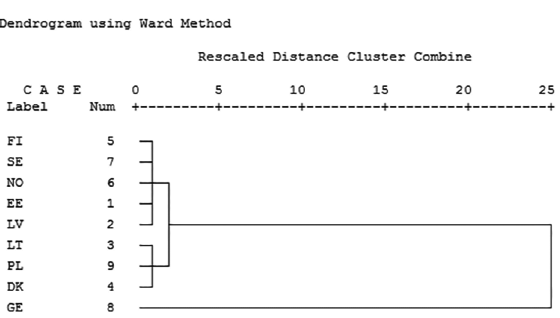
Fig. 9. Dendrogram representing the formation of countries’ clusters based on their road transport flow during 2004–2007